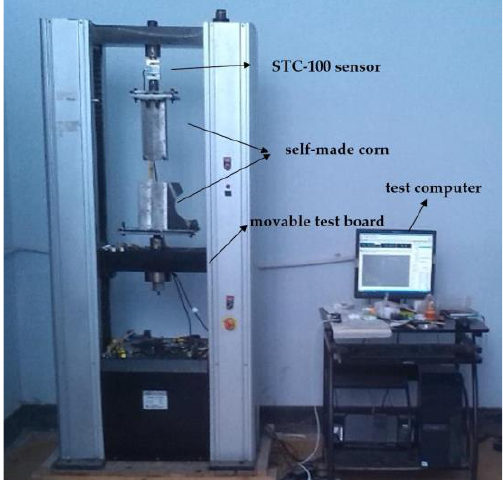
Figure 2. Electronic universal testing machine.